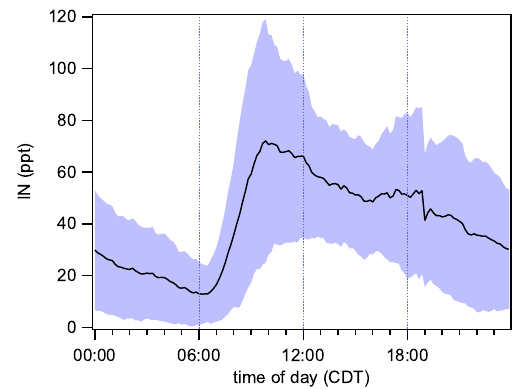
Figure 5. IN diurnal average from 28 May to 11 July. The blue shade indicates day-to-day variation (1 σ) . The abrupt drop of con- centration at 19:00 is caused by instrument fluctuation during its daily maintenance.